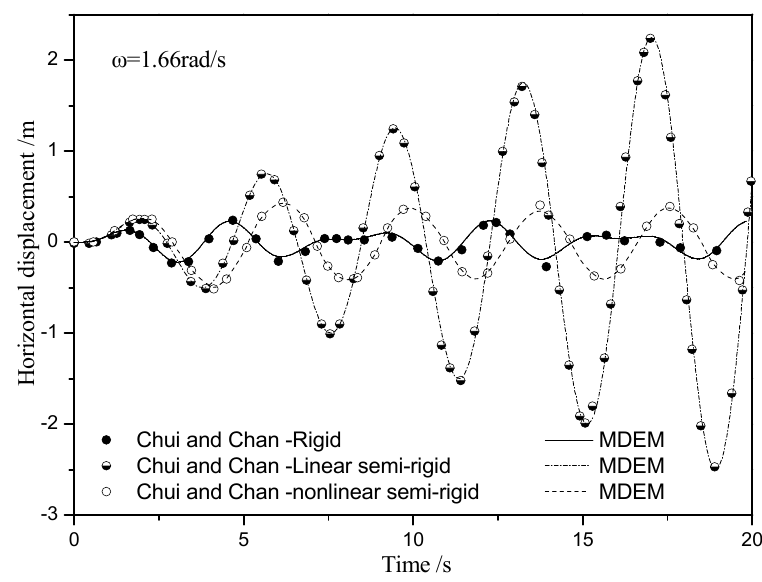
Figure 22. Horizontal displacement response of the top joint.